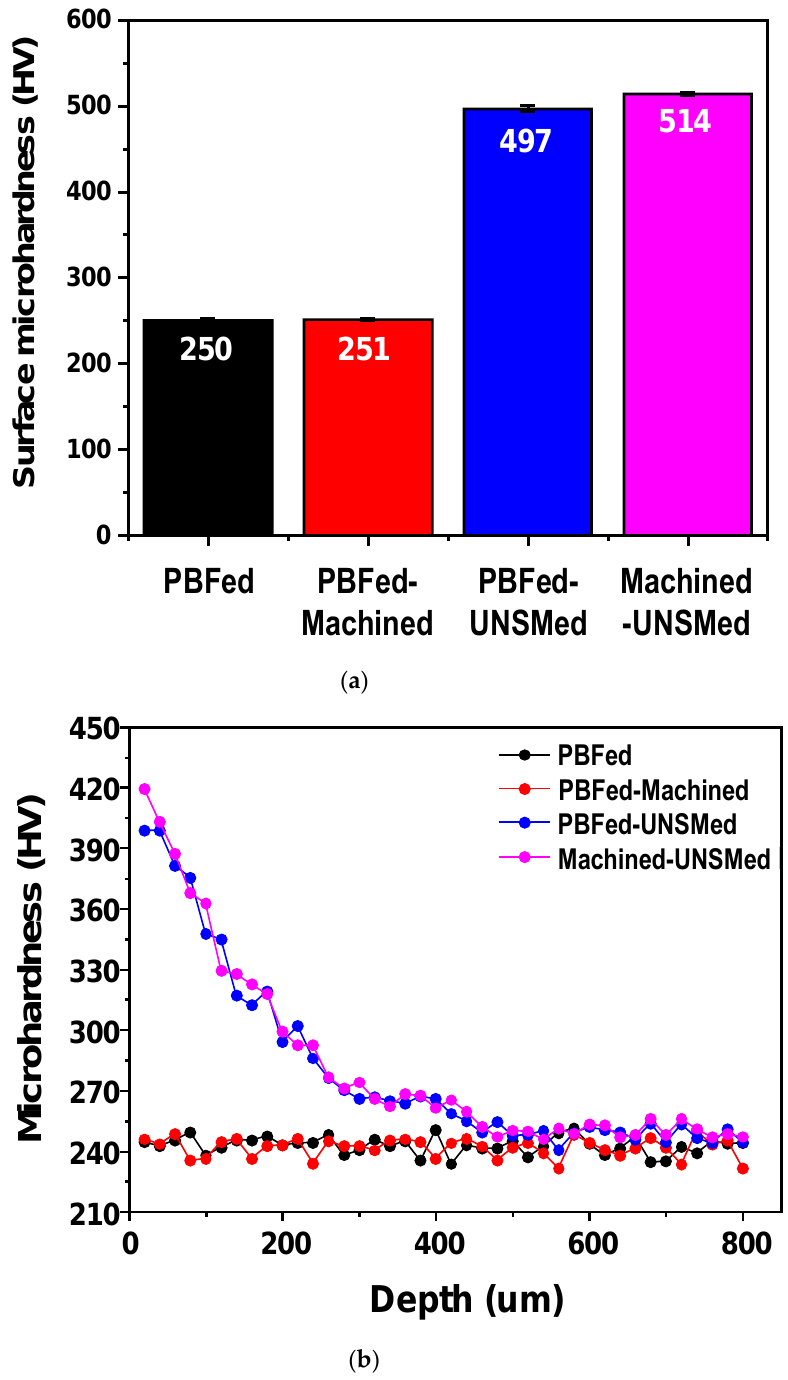
Figure 12. Comparison of ( a ) surface hardness of each sample and ( b ) microhardness variation with depth from top surface according to different treatments.